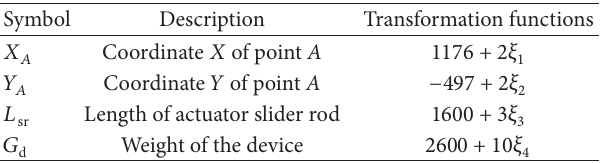
Table 2: Transformation functions of critical random parameters. Symbol